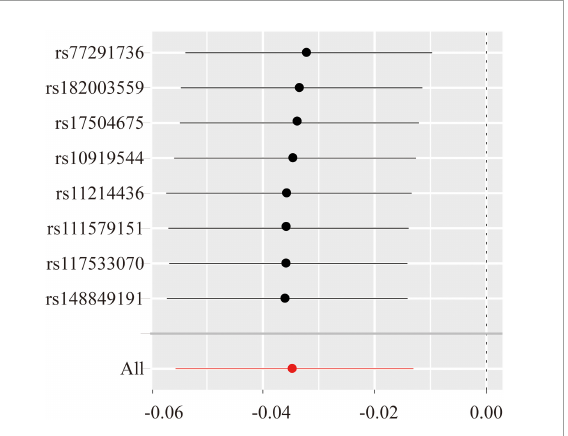
FIGURE4 The leave-one-single nucleotide polymorphism (ANP)-out sensitivity analyze for the expression level of CD16 - CD56 + on natural killer (NK) cells versus amyotrophic lateral sclerosis (ALS). The Y-axis shows the ID of the SNP to be omitted from analysis and the X-axis represents Mendelian randomization (MR) odds ratios. The red line shows MR estimate including all